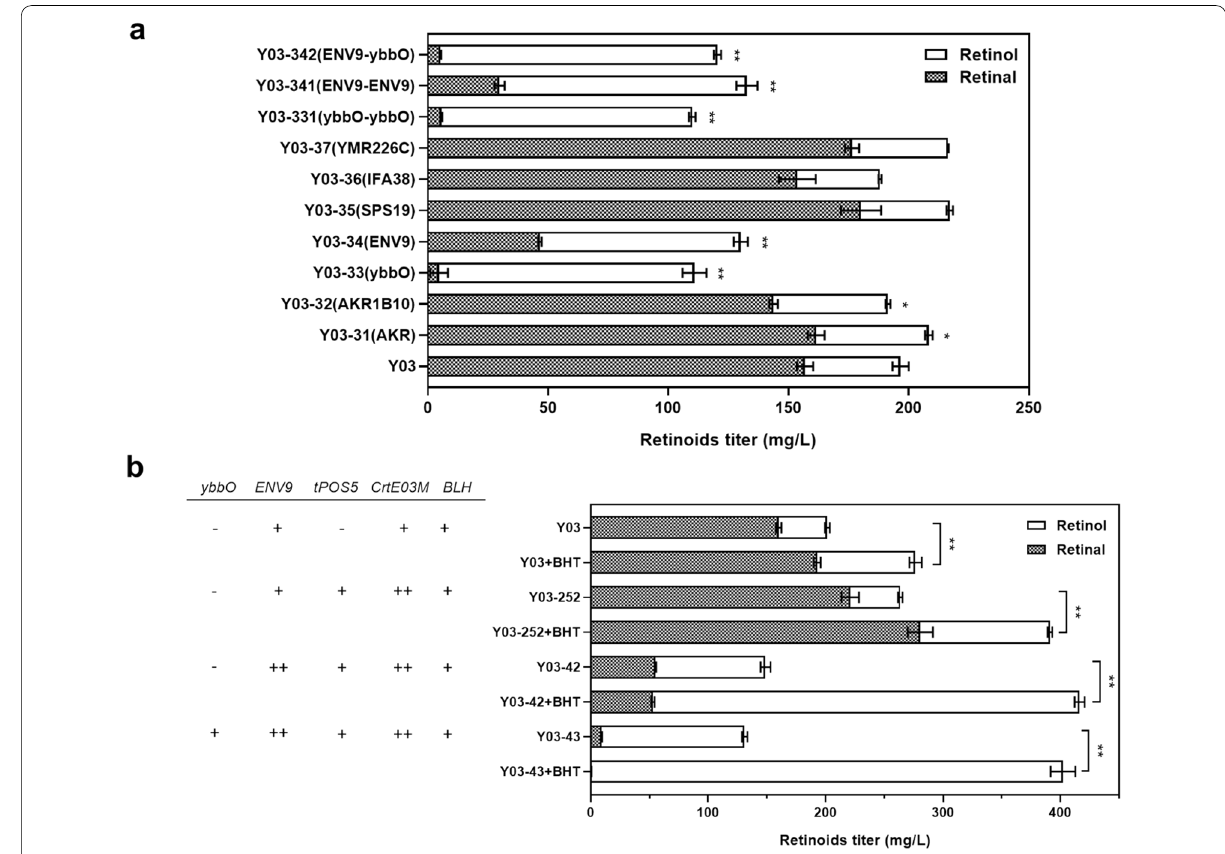
Fig. 5 Enhancement of retinol production through mining and evaluation of endogenous and exogenous alcohol dehydrogenases and investigation of the role of antioxidant BHT. a Effect of overexpressing endogenous or exogenous dehydrogenases on retinol formation. b Retinoids production by the engineered yeast strains in the absence and presence of BHT. The error bars represent standard deviations calculated from triplicate experiments and statistical significance of the different retinol levels in comparison with the control was evaluated using Student’s t test (*, P < 0.05; **, P < 0.01). ‘ ’ represents the introduction of exogenous genes or overexpression of endogenous genes, while its number represents the + copy number of the respective gene in the yeast